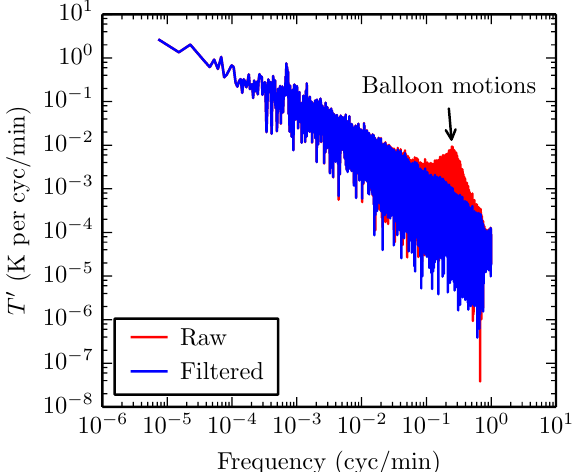
Figure 2. INC obtained from homogeneous nucleation at 195K forced by constant vertical velocity w for different values of the deposition coefficient α